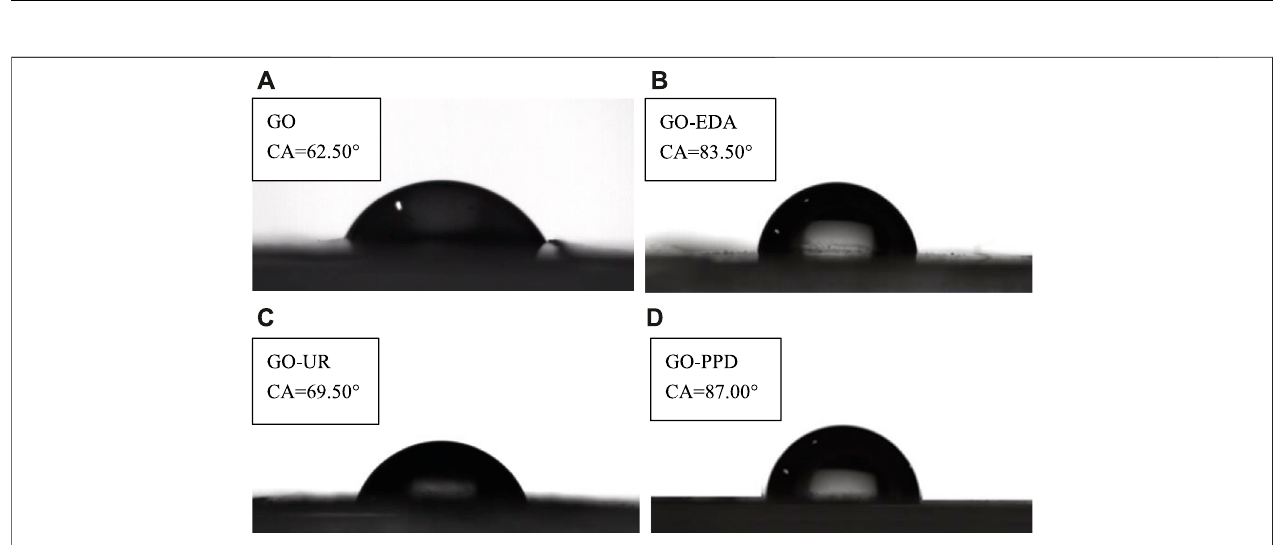
FIGURE 8 | Contact angles of the four membranes that have passed through the fi ltered salt solution (A) GO/MCE, (B) GO-EDA/MCE, (C) GO-UR/MCE, and (D) GO-PPD/MCE (wet state).